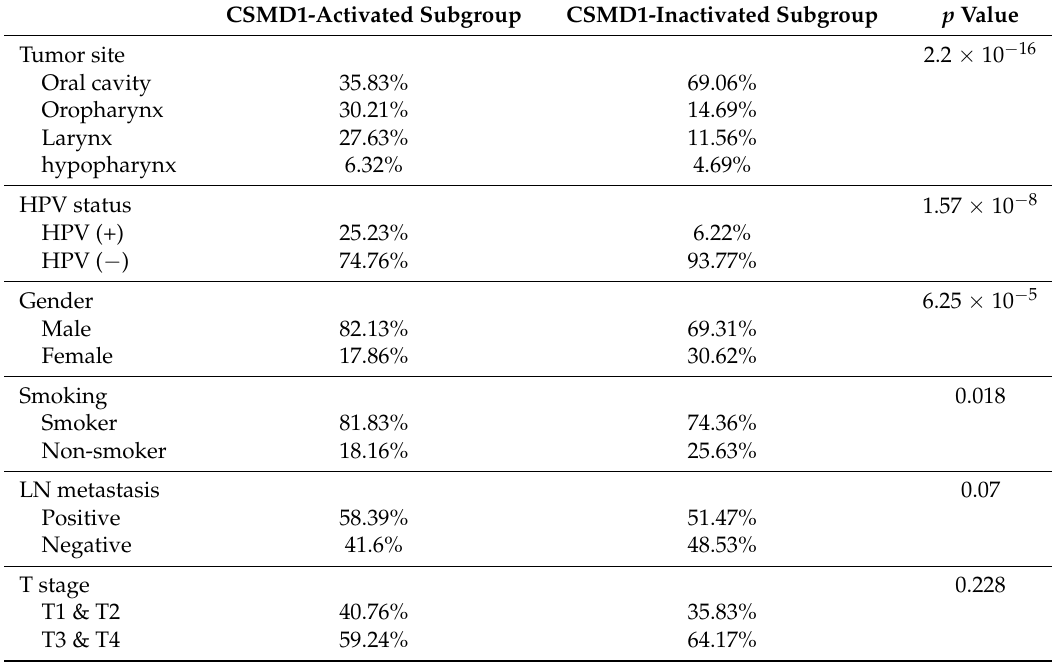
Table 3. Association with CSMD1 inactivation and clinicopathologic characteristics of